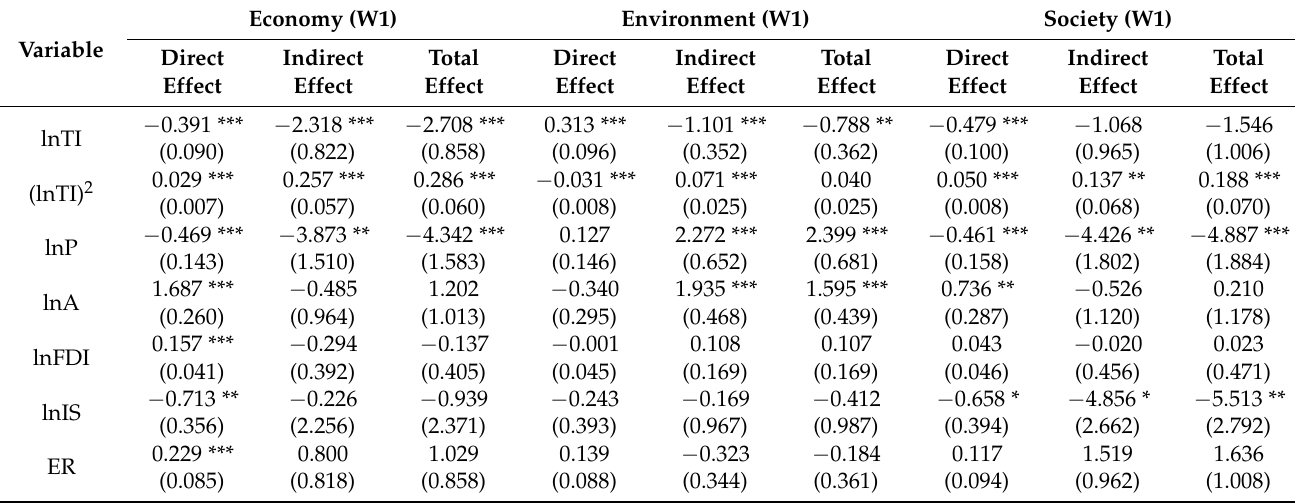
Table 6. Empirical results of three dimensions of green